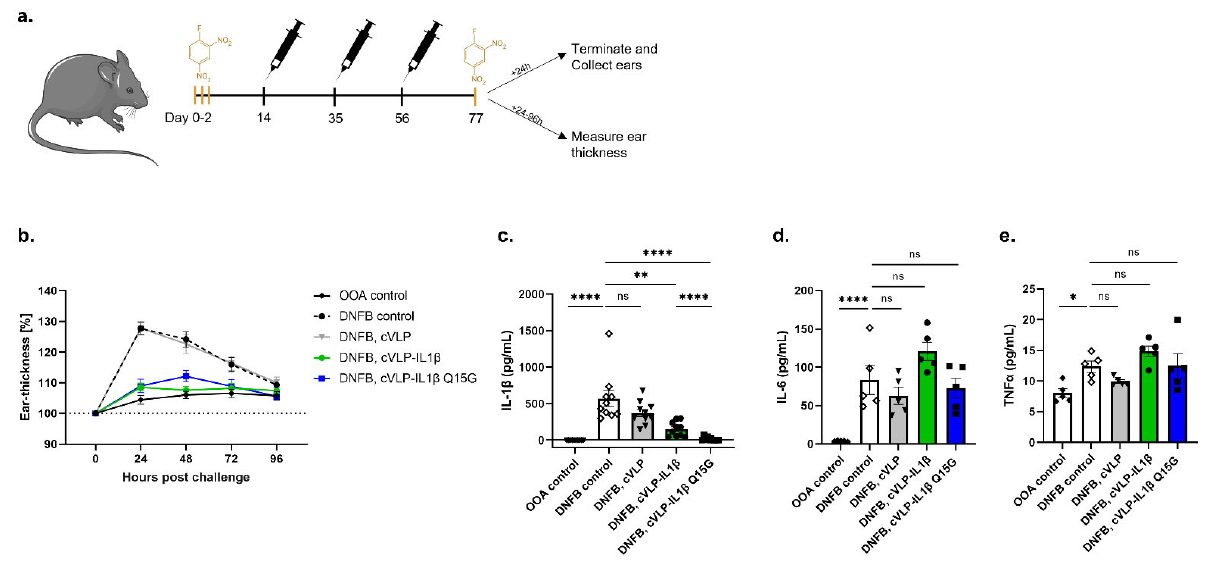
Figure 6 . cVLP:IL ‐ 1 β vaccination reduces ear thickness and IL ‐ 1 β levels after DNFB challenge. ( a ) Schematic outline of the murine ACD challenge model. Mice were sensitized to the ears with 0.15% DNFB for three consecutive days, followed by a three ‐ week prime ‐ boost ‐ boost immunization regime. The mice were subsequently challenged with 0.15% DNFB at the ears on day 77. The inflammatory response was followed in groups of mice, either by measuring the IL ‐ 1 β level in inflamed ear tissue (top) or by measuring the ear thickness for up to 96 h post challenge (bottom). Graphs show data from two technical replicates ( n = 5). ( b ) Ear thickness measured on groups of mice ( n = 10) 24 h, 48 h, 72 h, and 96 h post ‐ challenge, depicted as percentage (%) with mean ± SEM. ( c – e ) cytokine levels (i.e., ( c ) IL ‐ 1 β , ( d ) IL ‐ 6 and ( e ) TNF α ) with mean ± SEM measured in ear tissue from groups of mice ( n = 5, two technical replicates) sensitized and challenged with (1) OOA, (2) 0.15% DNFB, (3) 0.15% DNFB and vaccinated with unconjugated cVLP, (4) 0.15% DNFB and vaccinated with cVLP:IL ‐ 1 β and (5) 0.15% DNFB and vaccinated with cVLP:IL ‐ 1 β Q15G. Statistical analysis was performed on log ‐ transformed values using one ‐ way ANOVA, Tukey’s multiple comparisons test (adjusted p ‐ value < 0.05 was accepted as significant, * < 0.05, ** < 0.01, **** < 0.0001).